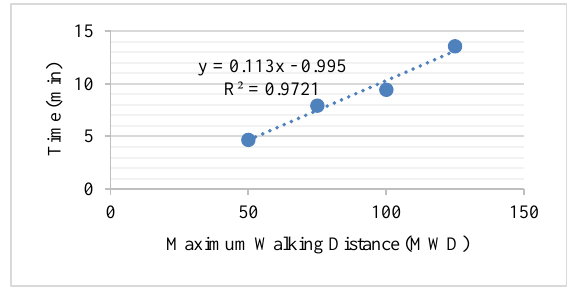
Figure 15. Performance